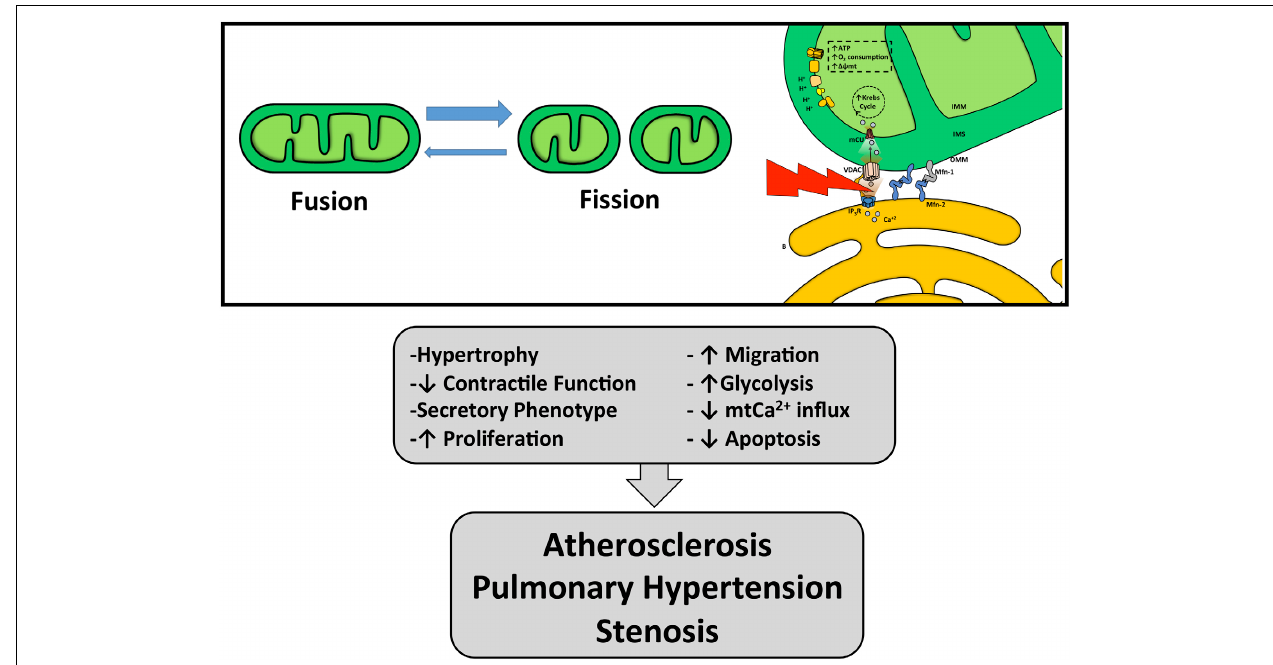
FIGURE 3 | Effects of mitochondria and ER–mitochondrial coupling dysfunction. Unbalance in mitochondrial dynamics and ER–mitochondria uncoupling can lead to VSMC phenotypic switching promoting vascular pathologies such as atherosclerosis, stenosis and pulmonary